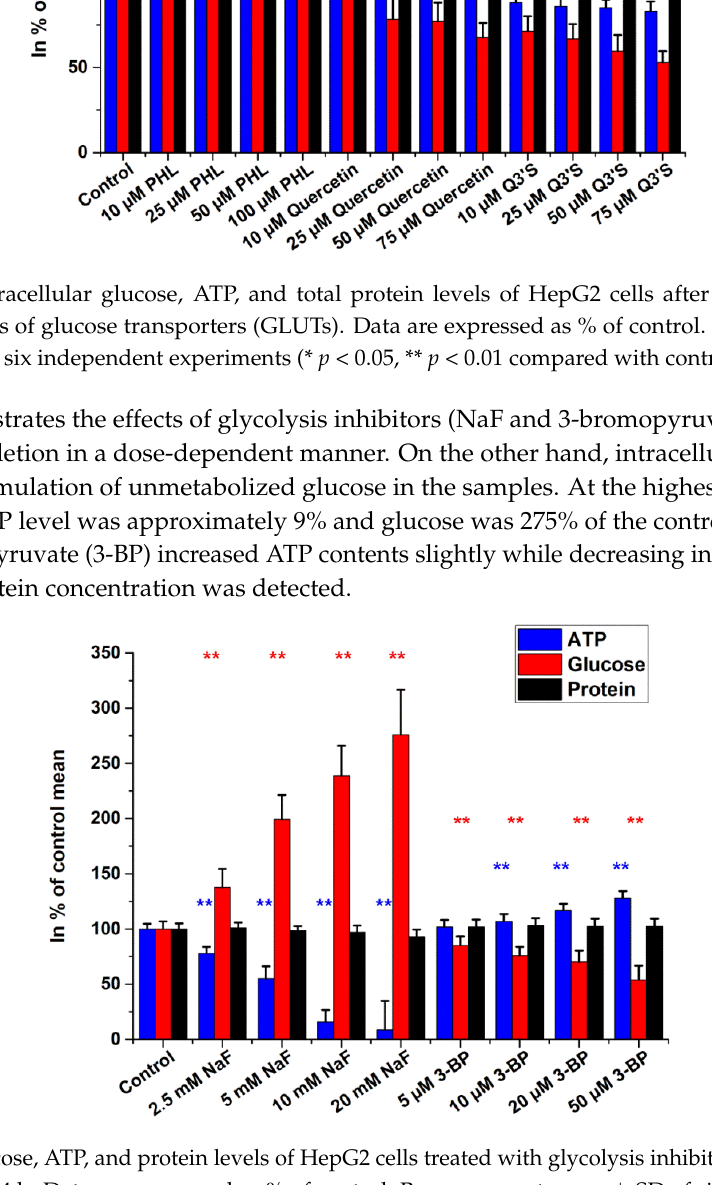
Figure 5. Glucose, ATP, and protein levels of HepG2 cells treated with glycolysis inhibitors. Cells were incubated for 4 h. Data are expressed as % of control. Bars represent mean ± SD of six independent experiments (* p < 0.05, ** p < 0.01 compared with controls).